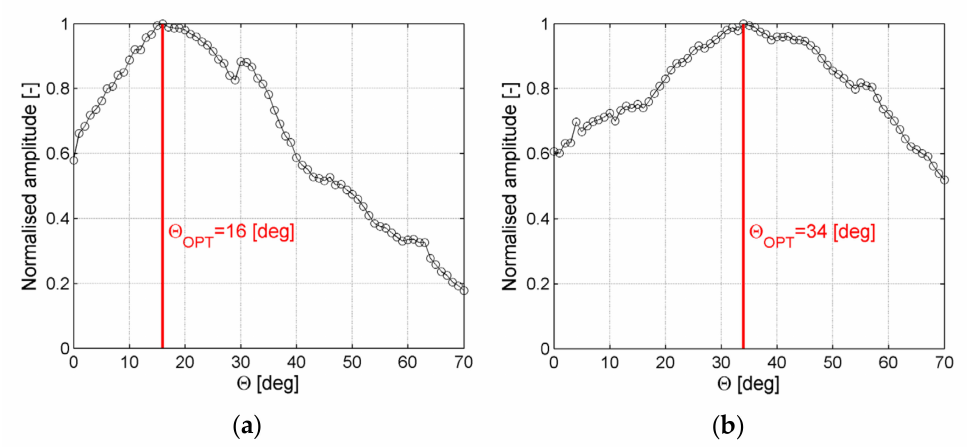
Figure 13. Normalized amplitude of the A 0 wave mode in a function of ACT slope angle θ for wave generation: ( a ) along reinforcing fibers, ( b ) across reinforcing